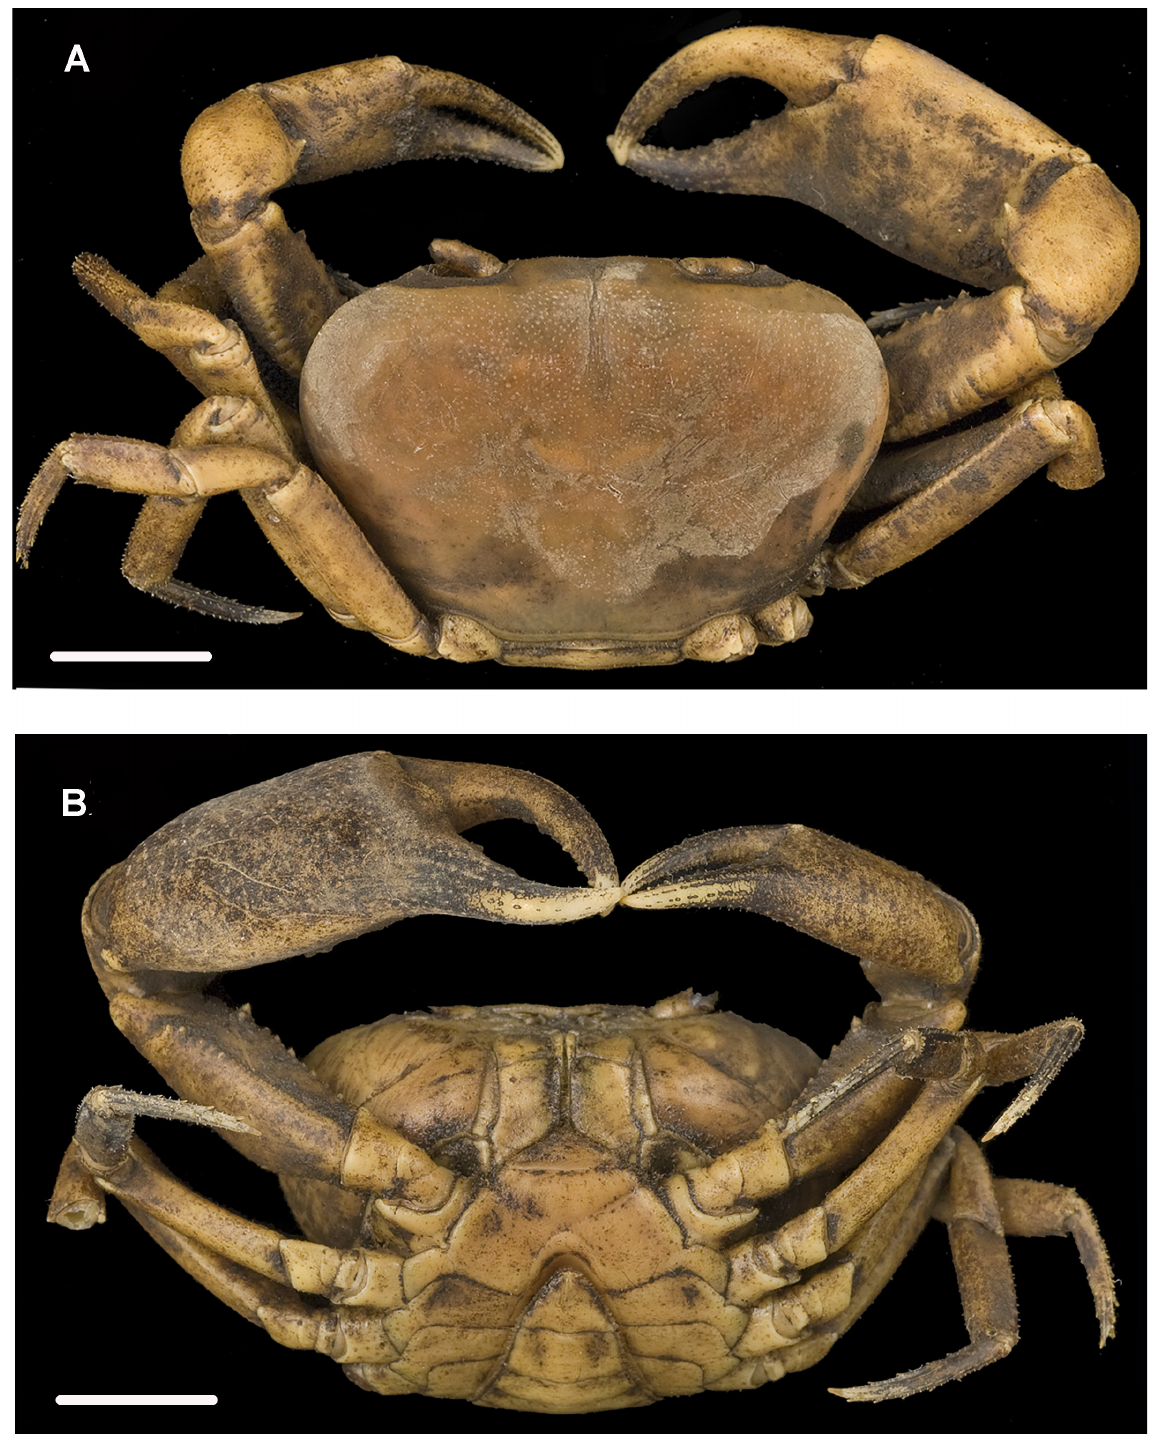
Fig. 1. Potamonautes entebbe sp. nov., holotype, adult ♂, CW 35 mm, from Entebbe, southern Uganda (NHMUK 1955.11.8.26). A . Whole animal, dorsal view. B . Whole animal, ventral view . Scale bars: 6.3 mm. Photographs by Phillip Crabb,